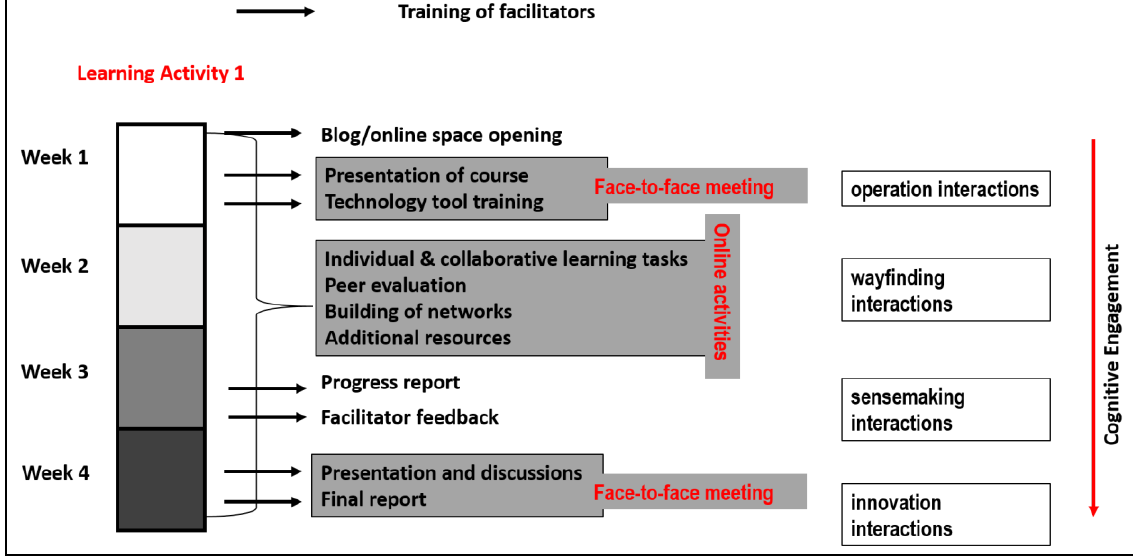
Figure 2 . Operational model for a learning